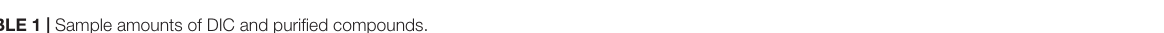
) of the E. huxleyi and T. pseudonana cultures. Errors bars are ± 0.1 (cid:104)